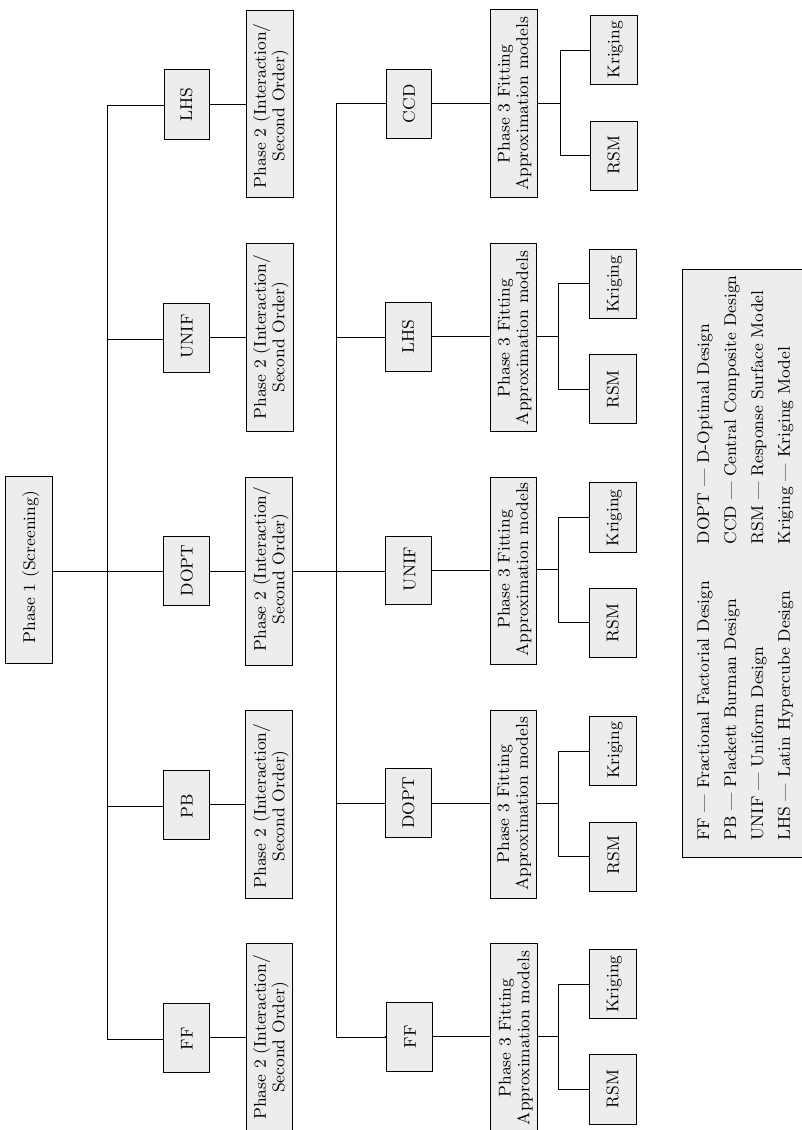
Figure 3: Methodology used for comparing different design and approximation model combi-